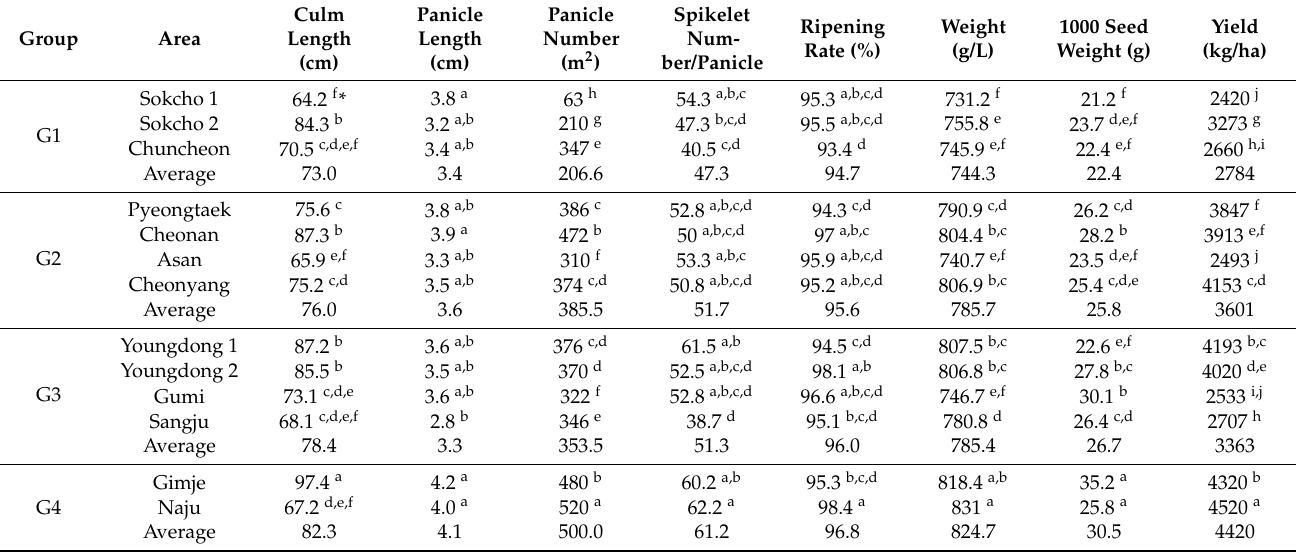
Table 4. Yield components and yield of dehulled barley plants in different group areas at harvest in